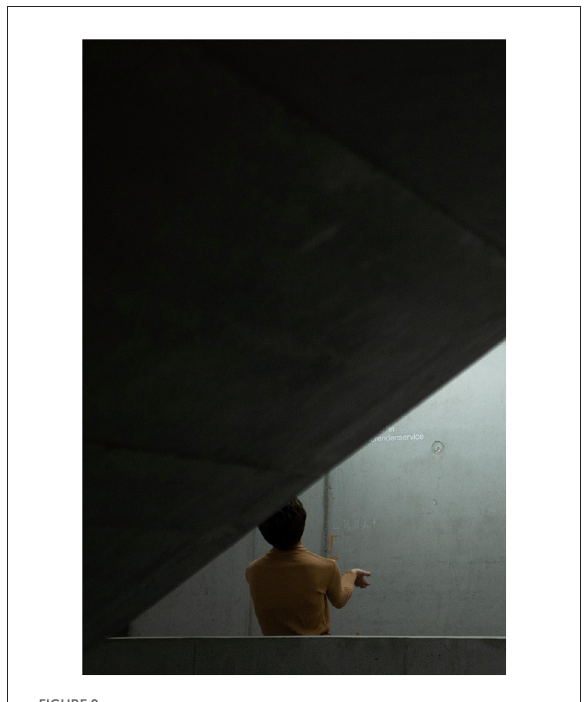
FIGURE9 Samuel Feldhandler tracing lines in architecture as a dance practice. Photo: Niels